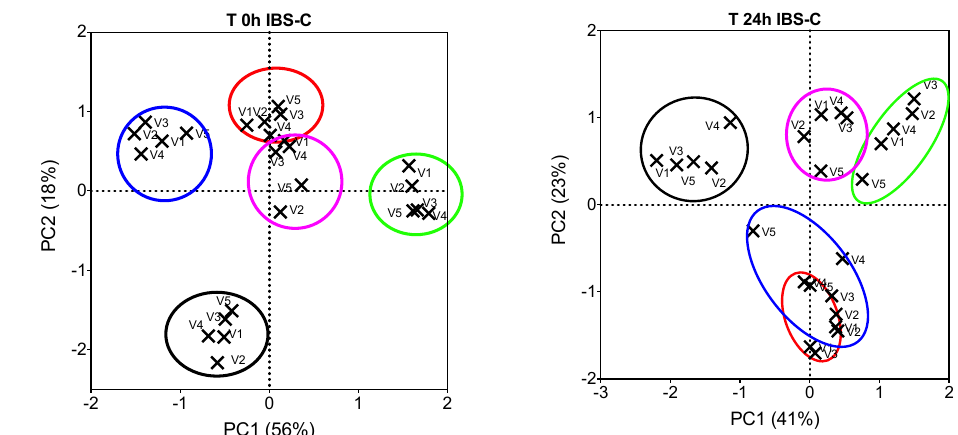
Figure 5. Score plot of the principal component analysis representing the variation in bacterial